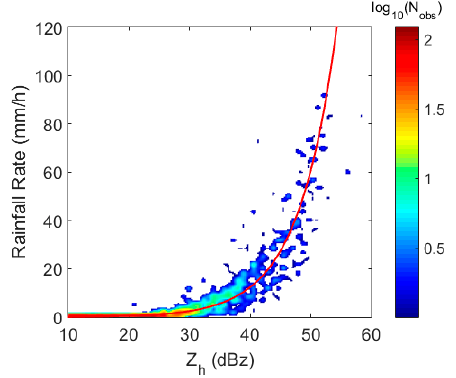
Figure 10. Scattergram of DSD-estimated rainfall rate ( R ) and Z h for CINRAD. The red solid line is the best-fitted power-law of R ( Z h )